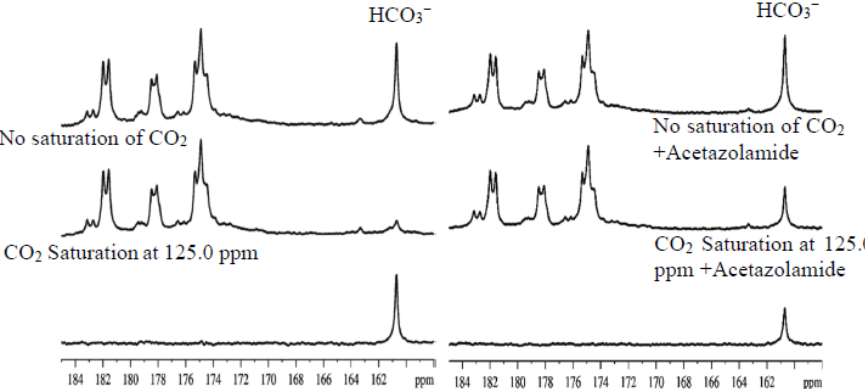
Figure 6. In vivo 13 C magnetization transfer effect of carbon dioxide–bicarbonate exchange in rat brain before ( left ) and after ( right ) carbonic anhydrase inhibition. Upper traces: no saturation of carbon dioxide. Middle traces: with saturation of carbon dioxide at 125.0 ppm. Lower traces: difference spectra. The 13 C magnetization transfer effect of the carbon dioxide–bicarbonate exchange was significantly reduced after blockade of carbonic anhydrase (adapted from ref [40] with permission from John Wiley and Sons Ltd.).